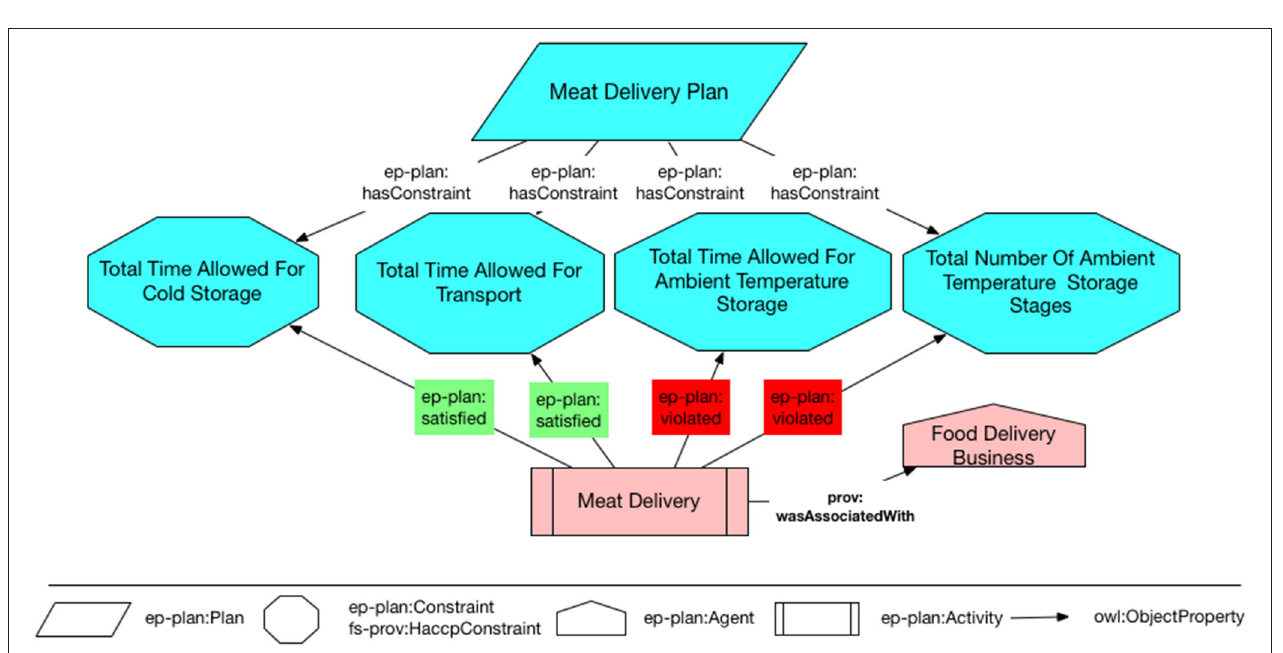
FIGURE 7 | An overview of the high level constraints associated with the delivery plan and their relationship to the high level food delivery activity.